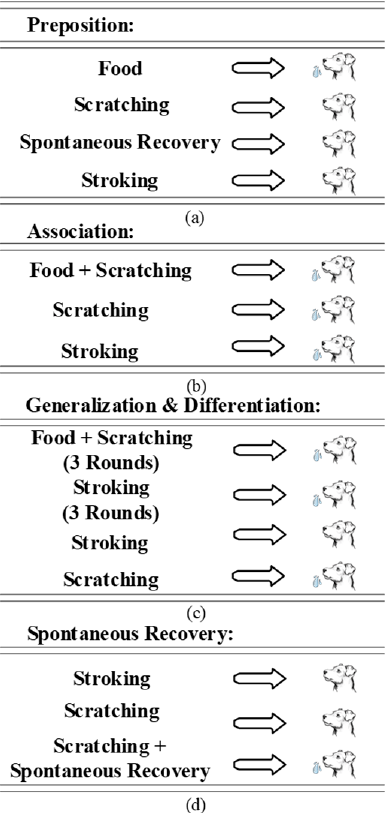
Figure 1. Illustration of Pavlovian conditional reflex. ( a ) Brief description of the preposition of the experiment. ( b ) Training scheme for dogs to associate unrelated things. ( c ) Generalization and differentiation experiment. ( d ) Spontaneous recovery principle.